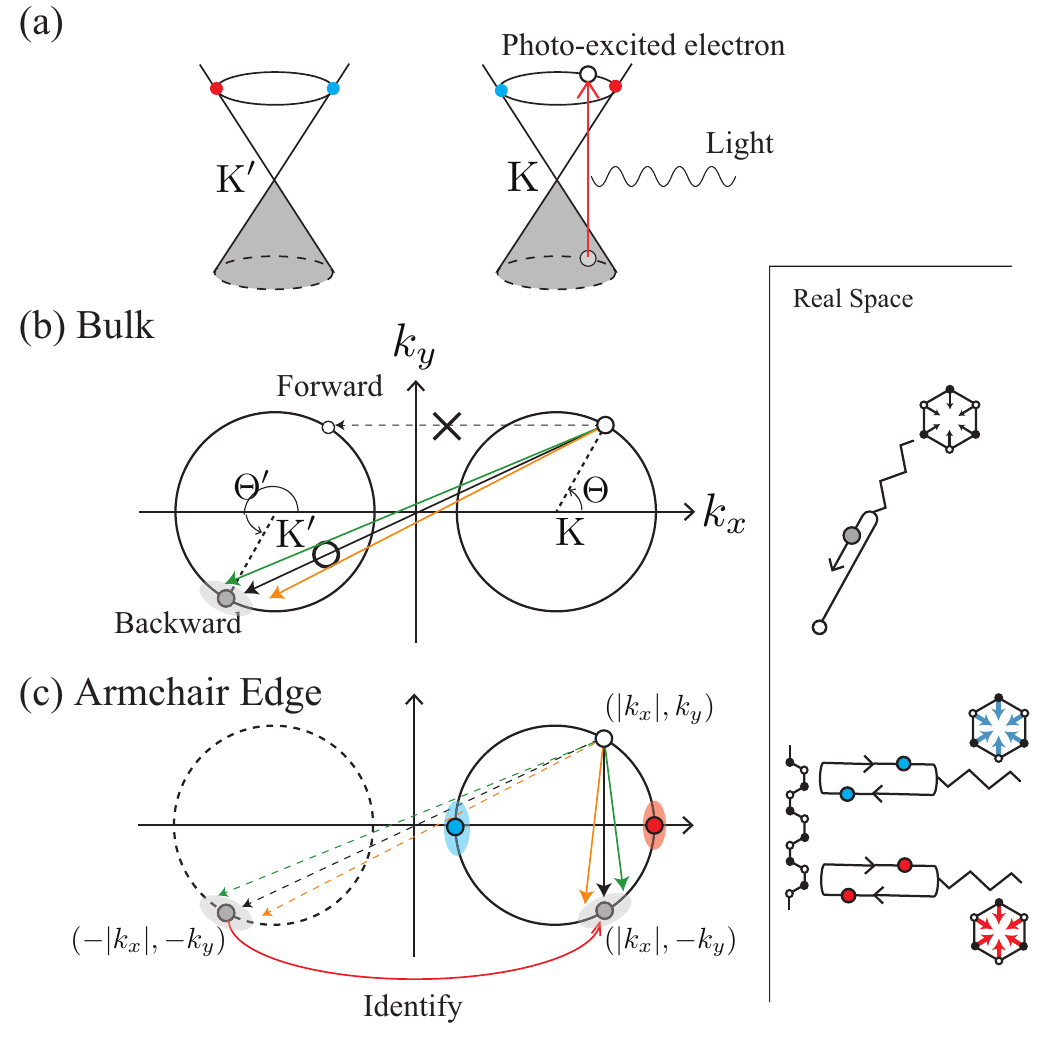
Figure 2. Mechanism of D band intensity enhancement at armchair edge. ( a ) A photo-excited electron near the K point; ( b ) The electron-phonon interaction of an zone-boundary A mode results in the dominance of intervalley backward scattering; 1 g ( c ) The BZ folding leads to the appearance of two special electronic states (with the bonding [red] and antibonding [blue] orbitals): an A mode can be excited from them through a 1 g first-order Raman process. In real space, this is represented by the fact that the color of the points does not change while emitting an A 1 g